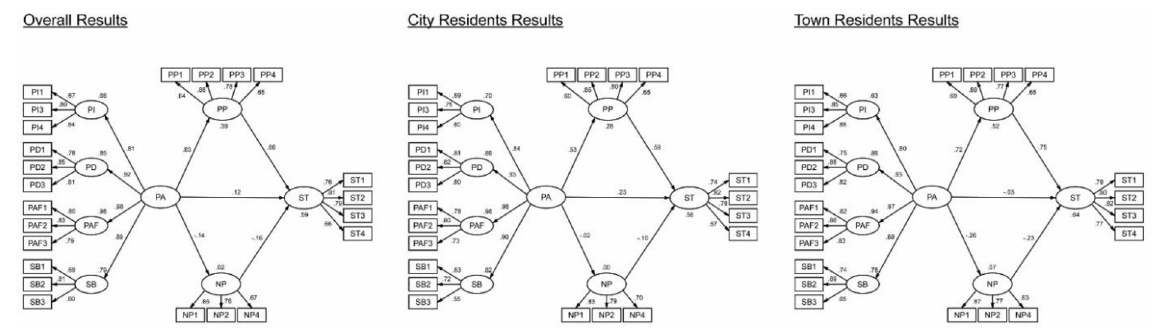
Fig 3. SEM results for the three groups.